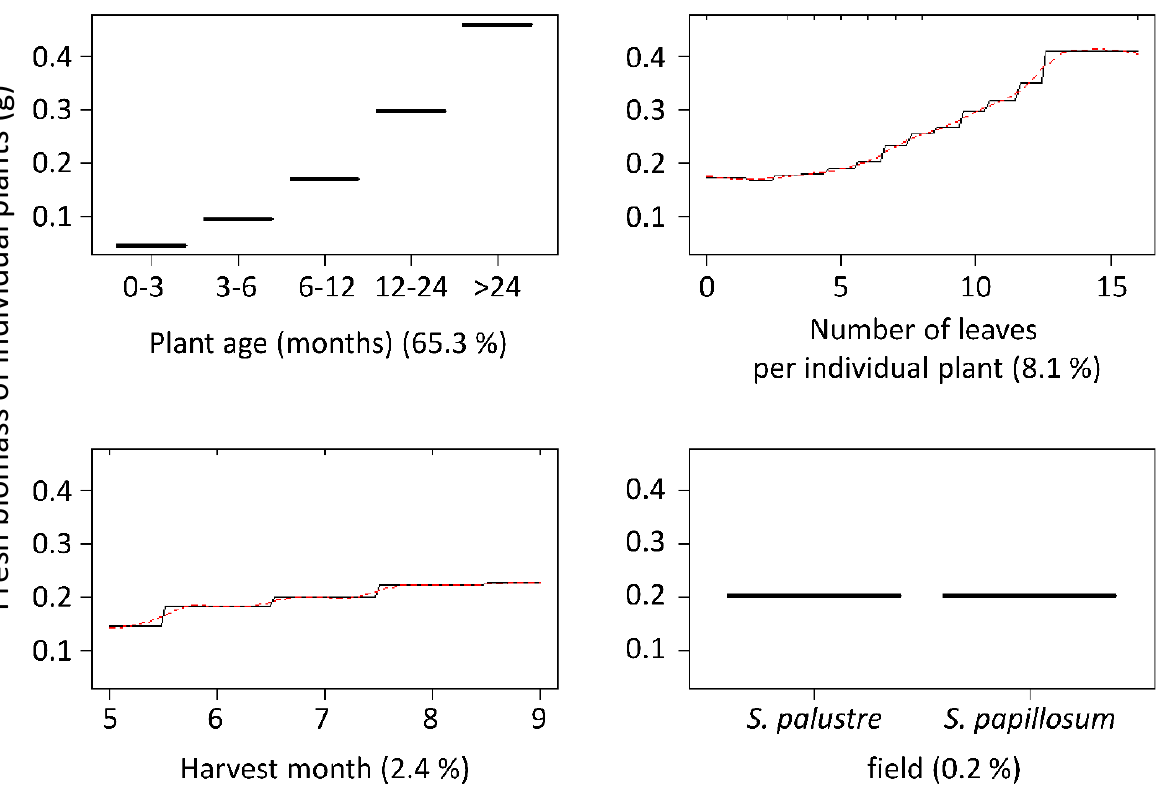
Figure 3. Boosted regression tree model of Drosera rotundifolia biomass (response variable) and predictor/explanatory variables plant age, number of leaves per individual plant, harvest month and Sphagnum species. Percentages indicate the absolute contribution of the variable to the total biomass. The boosted regression tree model was performed with 5907 observations and four predictors, using Gaussian distribution, with tree complexity = 5 (sets the complexity of individual trees, interaction order), learning rate = 0.01 (sets the weighting applied to individual trees, shrinkage factor), bag fraction = 0.75 (sets the proportion of observations used in selecting variables). The final model was fitted with 1200 trees with explained deviance = 0.7654. Table 1. Mean fresh mass (FM) of individual Drosera rotundifolia plants growing on Sphagnum palustre and Sphagnum papillosum fields. Flowering = plants with stalk(s); Non-flowering = plants without stalk(s); Total = flowering + non-flowering plants. Harvest dates: June–September 2013 and May–September 2014 ( n = 23 per Sphagnum species; 2013: 2 plots × 4 months; 2014: 3 plots × 5